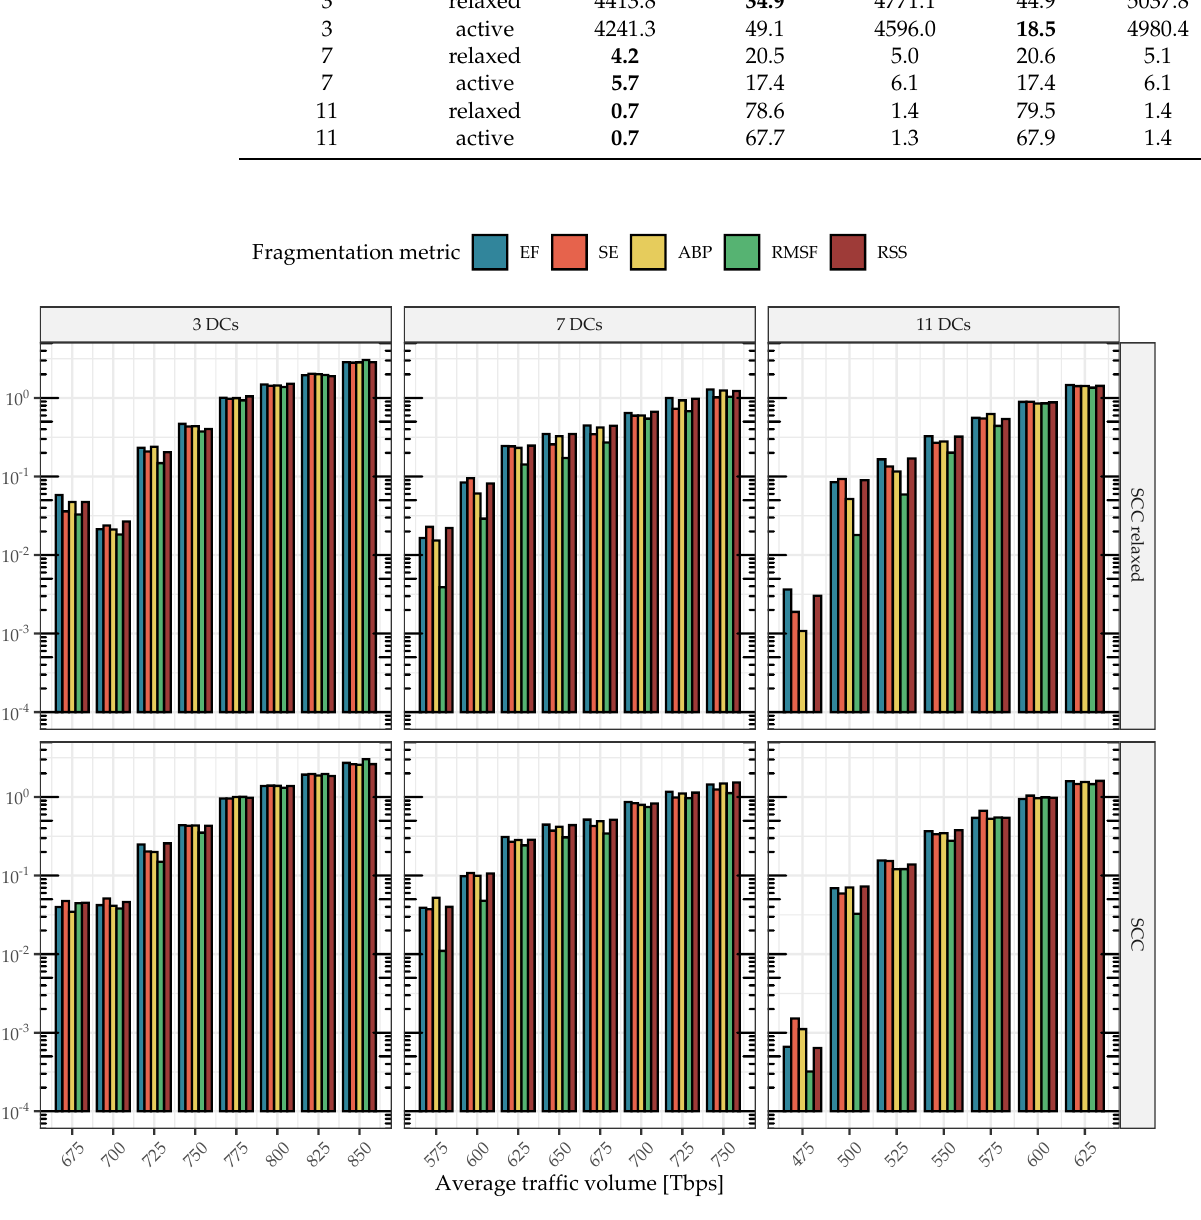
Figure 5. BBP as a function of various fragmentation metrics for the FragA-TG